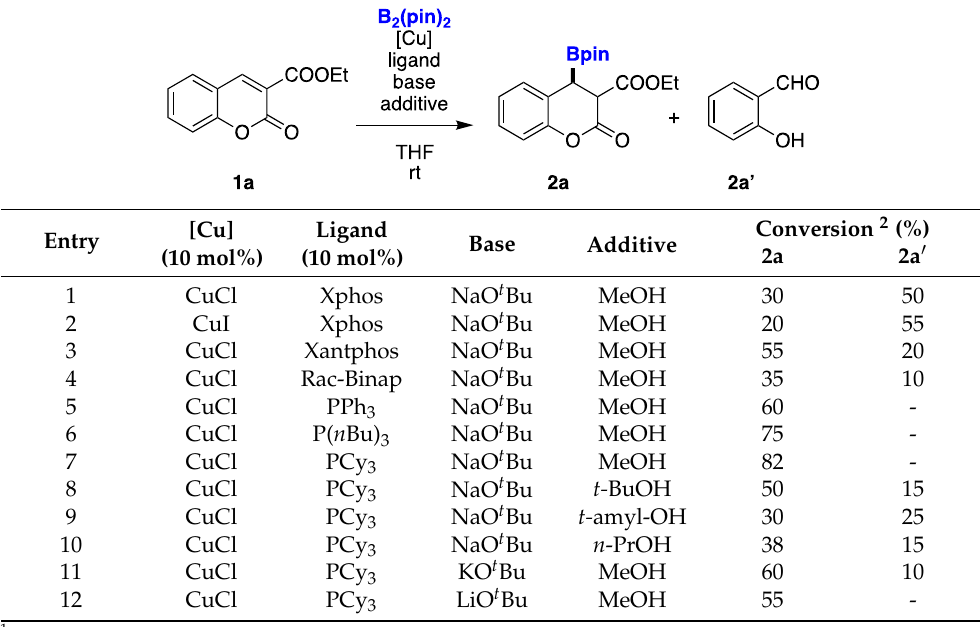
Table 1. Optimization of reaction conditions for 1,4 borylations of oxacycles 1 .